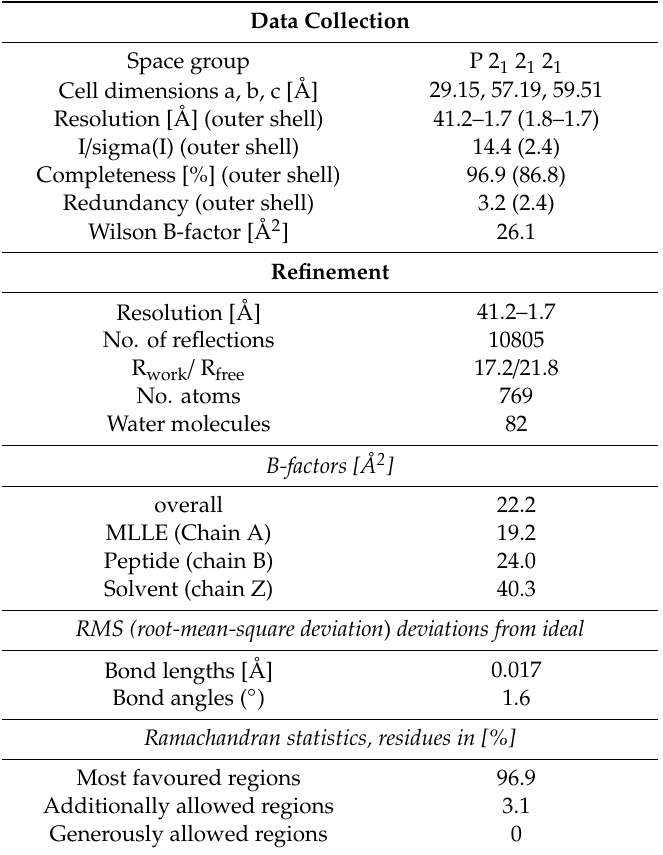
Table 1. Crystallographic data collection and refinement